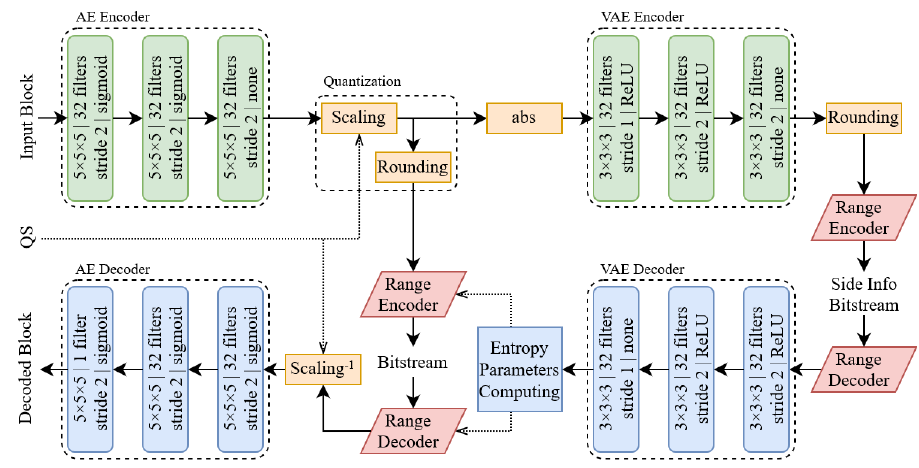
Figure 18. Architecture proposed in [108].